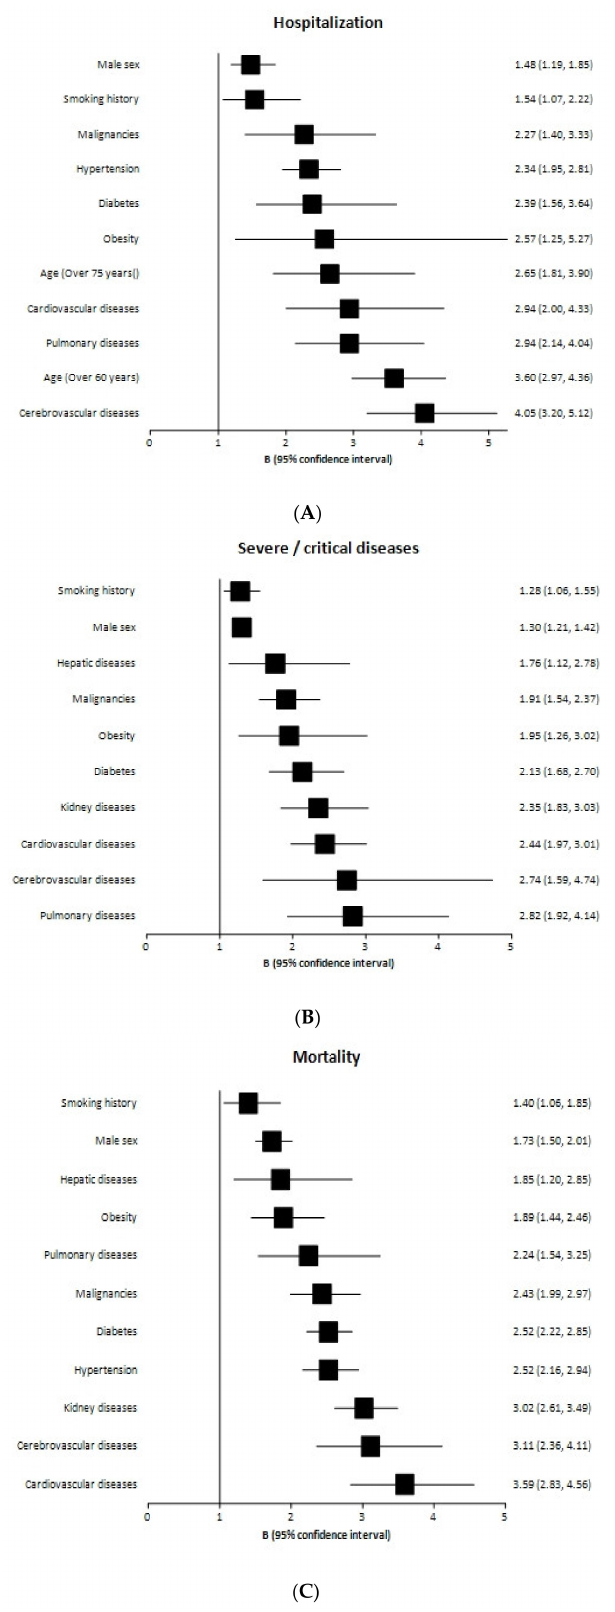
Figure 3. Forest plot of pooled odds ratio and 95% confidence intervals of the different patients’ characteristics and underlying conditions for ( A ) Hospitalization ( B ) Severe/critical condition, and ( C )